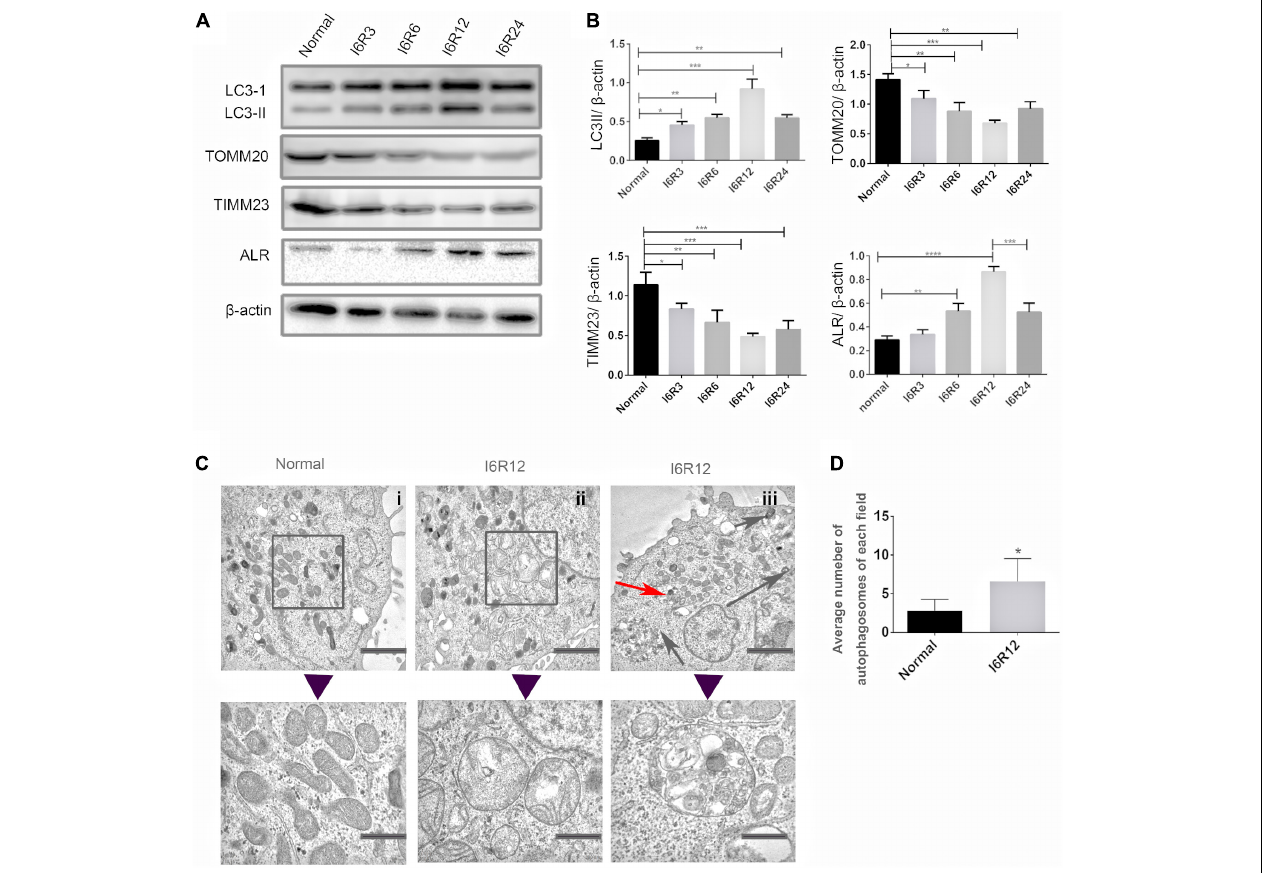
FIGURE 1 | Mitochondrial damage, mitophagy, and activation of augmenter of liver regeneration (ALR) were induced in HK-2 cells by ischemia–reperfusion (I/R). (A,B) Immunoblot analysis and quantification of ALR, LC3, translocase of outer mitochondrial membrane 20 (TOMM20), and translocase of inner mitochondrial membrane 23 (TIMM23). (C,D) Representative TEM images of mitochondrial morphology (square box), mitophagosomes (red arrow), and autophagosomes (black arrow) in HK-2 cells. The observation timepoint was I6R12. Data are shown as a bar graph of the number of autophagosomes from five images of each group. Scale bar: 2 µ m. The images in the lower row show the amplification of the normal mitochondria, damaged mitochondria, and mitophagosomes. Scale bar: 200 nm. Data represent means ± SD. n = 3. * p < 0.05, ** p < 0.01, *** p < 0.001, **** p <